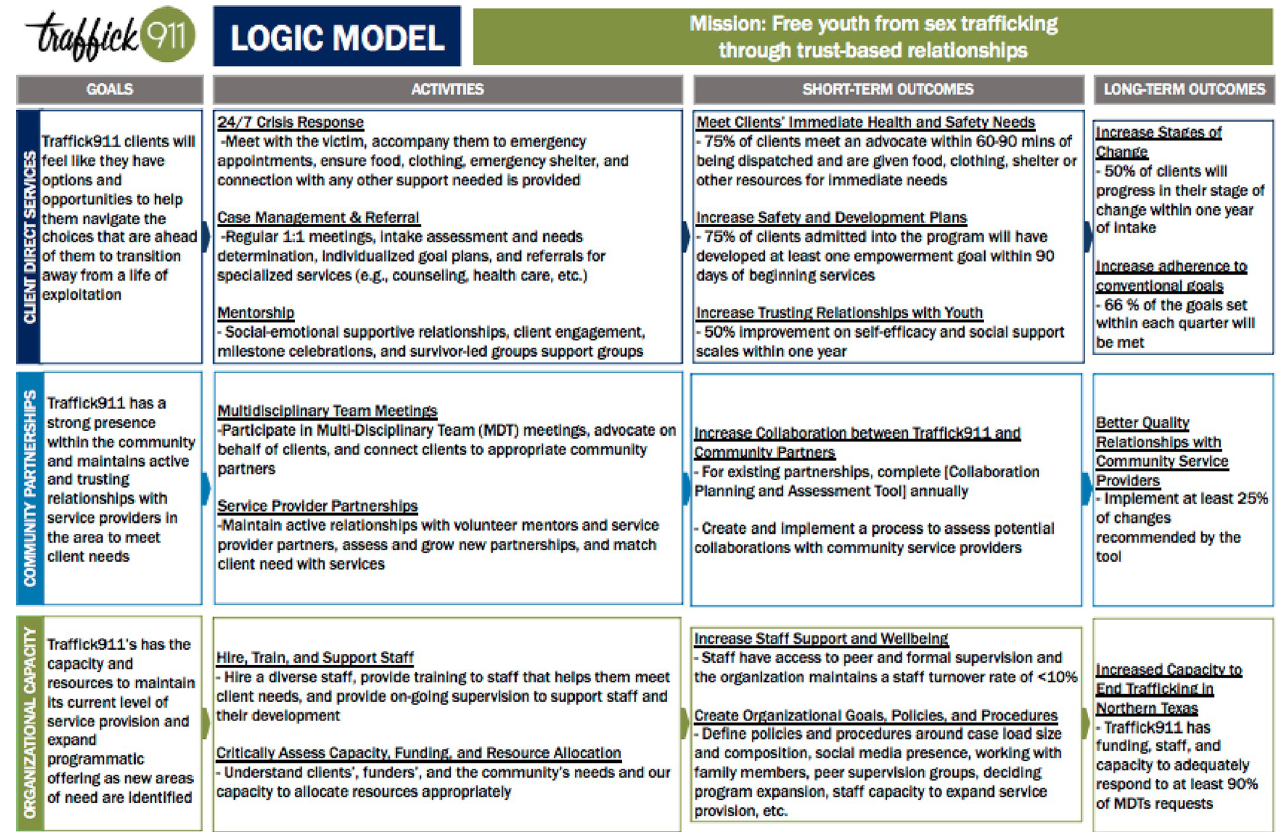
Fig 1. Program logic model. Traffick911 logic model demonstrating agency’s theory of change.